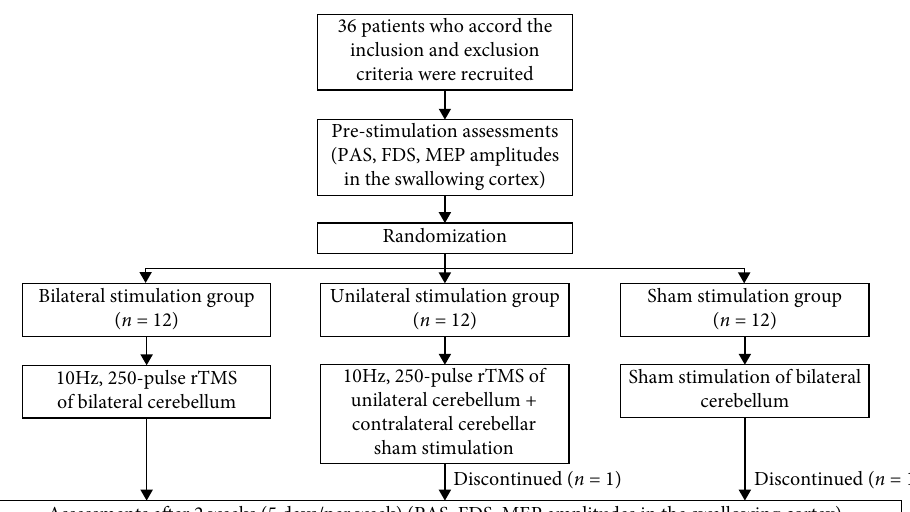
Figure 1: The study design and fl ow chart.